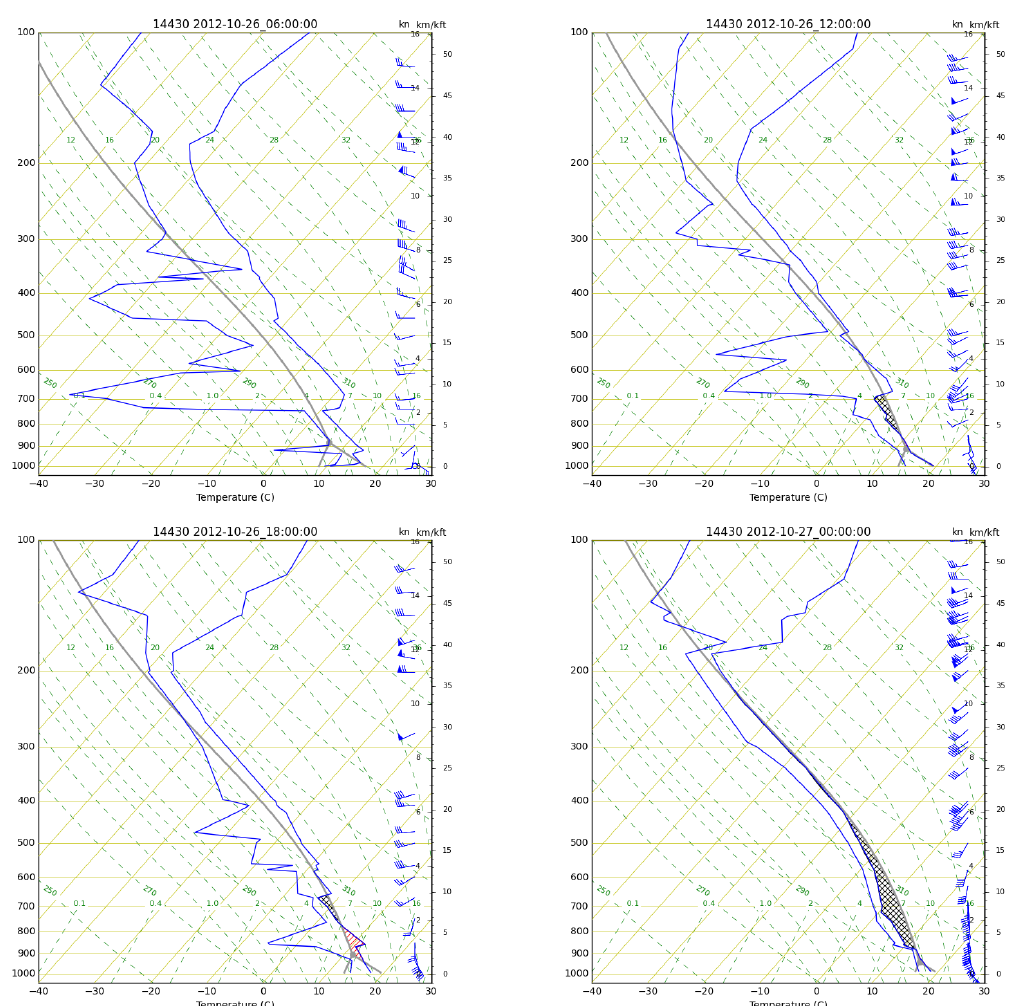
Figure 8. Radiosounding data for Zadar 26 October 2012 at 06:00 and 12:00UTC (first row), 26 October 2012 at 18:00UTC and 27 October 2012 at 00:00UTC (second